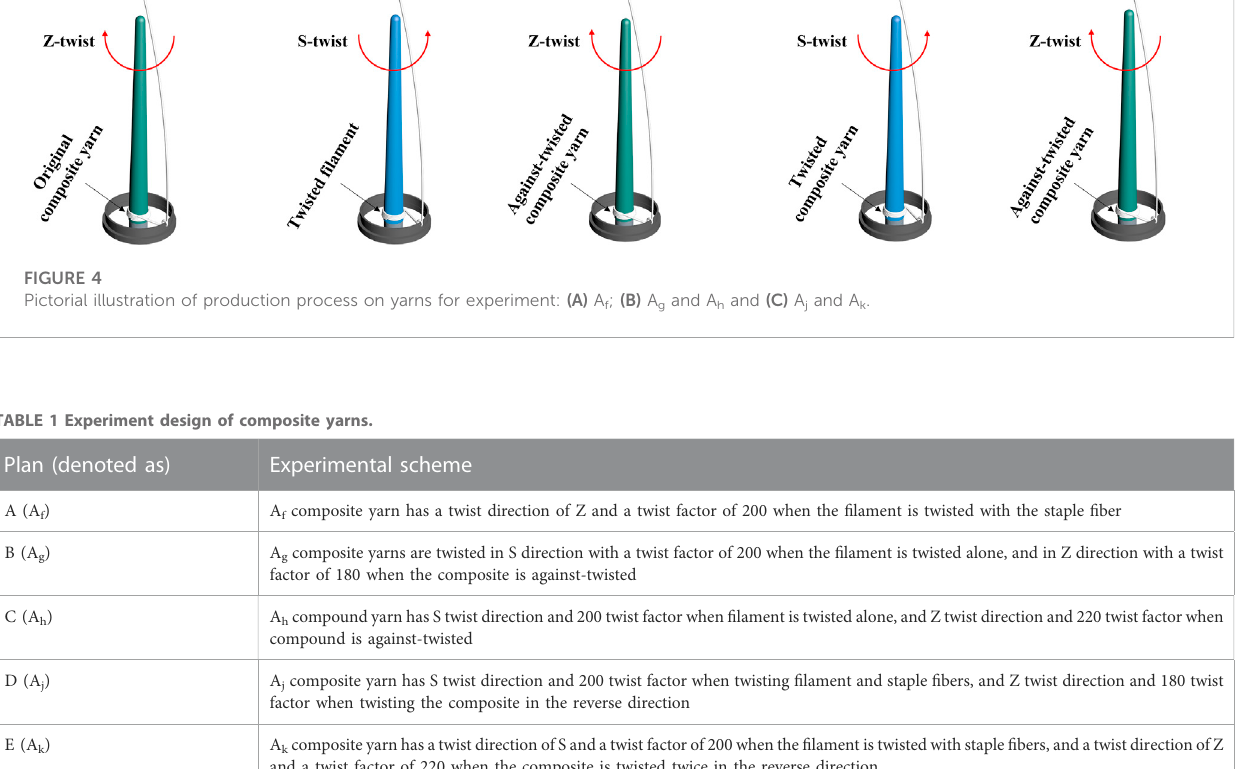
Figure 5 indicates the modulus value of cotton fi ber, basalt fi lament and the composite yarn of both, and it is evident that there exists a large difference in modulus between basalt and cotton fi bers.